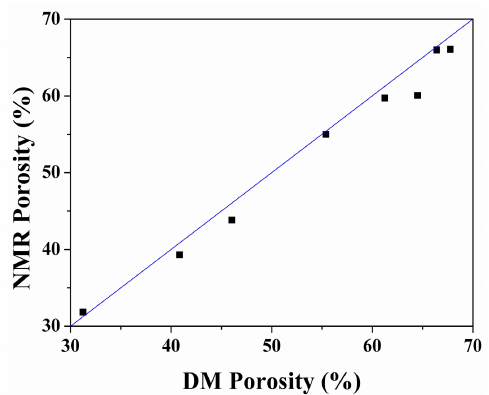
Figure 12. Comparison between the porosity of spent shale samples after sub-critical water extraction determined using the density measurement (DM) and nuclear magnetic resonance (NMR) methods.